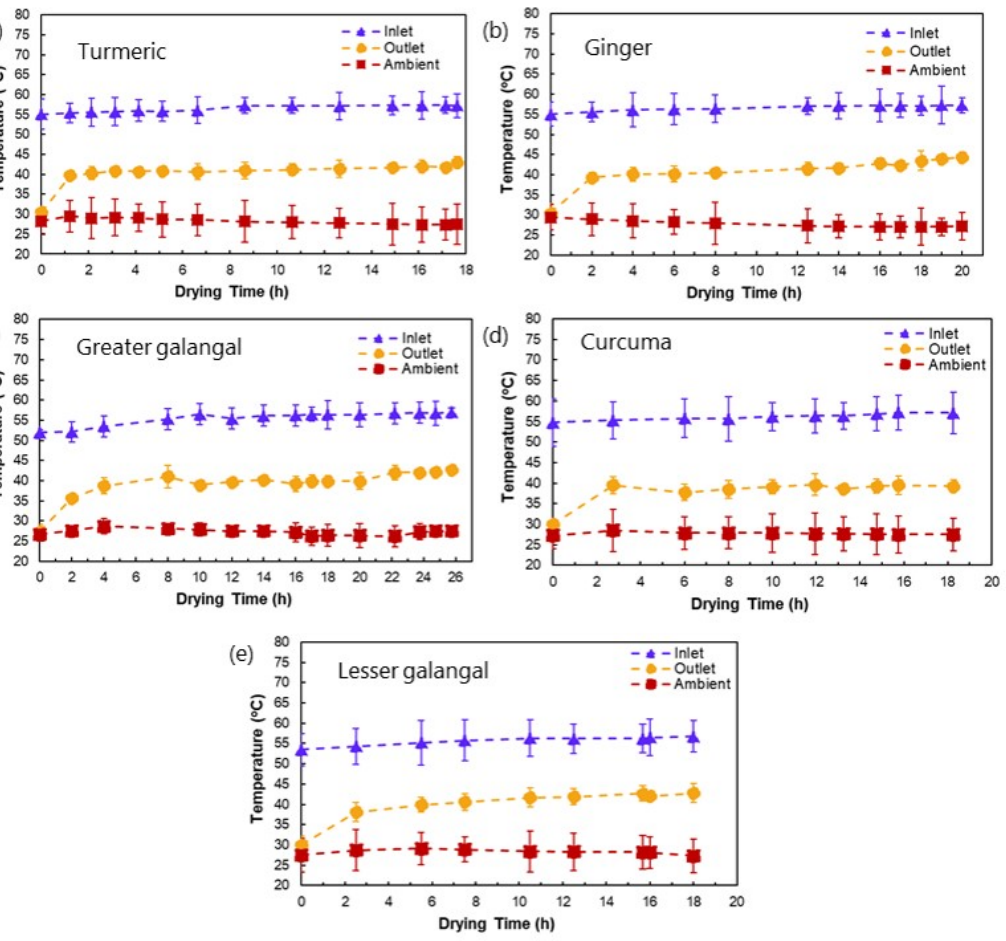
Figure 4. Temperature profiles of the ambient air and the drying cabinet in the Polydryer with the operation of a heater: ( a ) turmeric, ( b ) ginger, ( c ) greater galangal, ( d ) Curcuma, ( e ) lesser galangal.